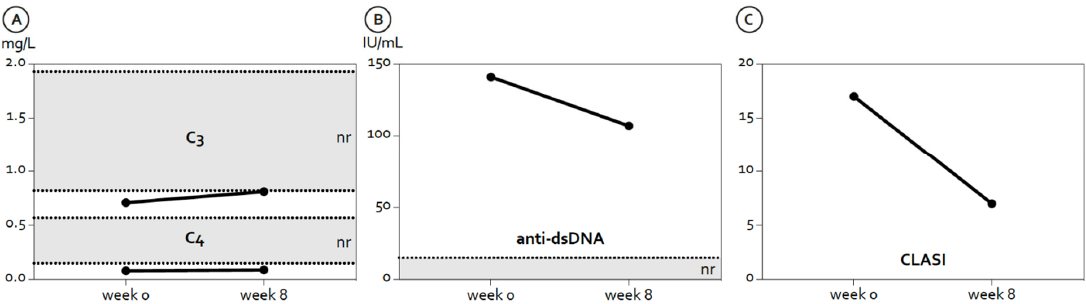
Figure 2. Changes in serologic parameters and the disease activity at baseline and after eight weeks. ( A ) Complement factors C3 and C4. ( B ) Anti-double stranded (ds) DNA levels. ( C ) Cutaneous lupus activity and severity index (CLASI).